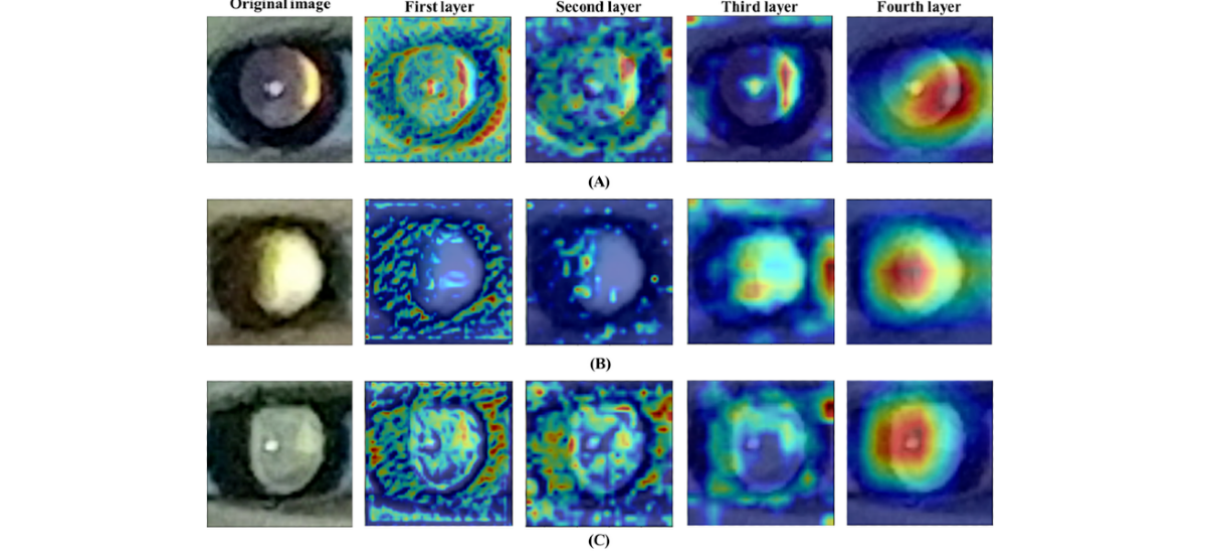
Figure 4. Examples of photorefraction images correctly classified by deep neural networks. (A), (B), (C) were identified as ≥ +0.5 D and <+3.0 D, ≥ +3.0 D and <+5.0 D, and ≥ +5.0 D, respectively. The first layers captured low-level features, such as edge and color. With deeper layers, the network focused on high-level features that were regarded as important aspects for